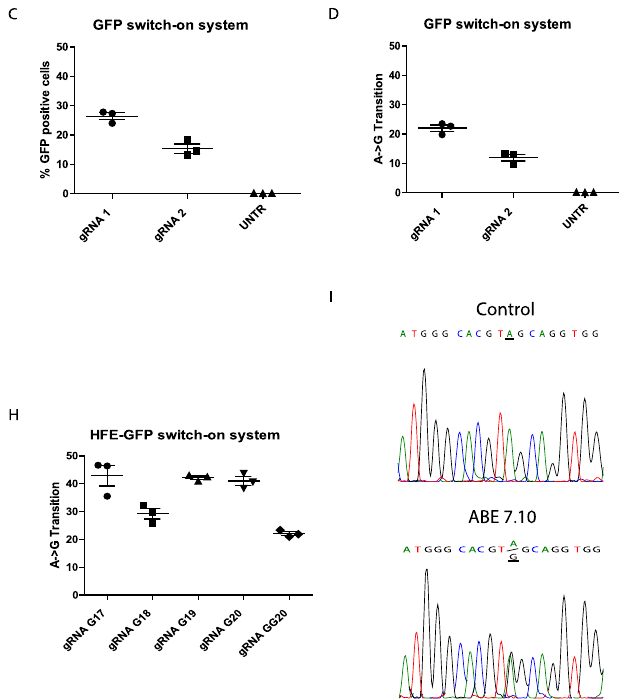
Fig. 1 | Cell culture-based base editing reporter system. A Depiction of GFP switch-off system. The start-ATG of the ORF is targeted by a gRNA directing ABE7.10.Uponediting,ATGwillbeconvertedtoGTG,leadingtotheinactivationof GFP expression. B Depiction of GFP switch-on system. Twenty nucleotides down- stream of the start-ATG, a premature stop codon TAG was inserted leading to a nonfunctional GFP. Base editing will result in the reconstitution of the gfp ORF. C Flow cytometric determination of GFP-positive HEK-293T cells (GFP switch-on system)upontransfectionwithgRNAsandABE7.10( n =3biologicallyindependent samples). The bars in the scatter dot plot depict the mean with the SD . D Deter- mination of base conversion rate via NGS. The gfp locus was PCR-ampli fi ed and subjected to NGS ( n =3 biologically independent samples). The bars in the scatter dotplotdepictthemeanwiththeSD .E